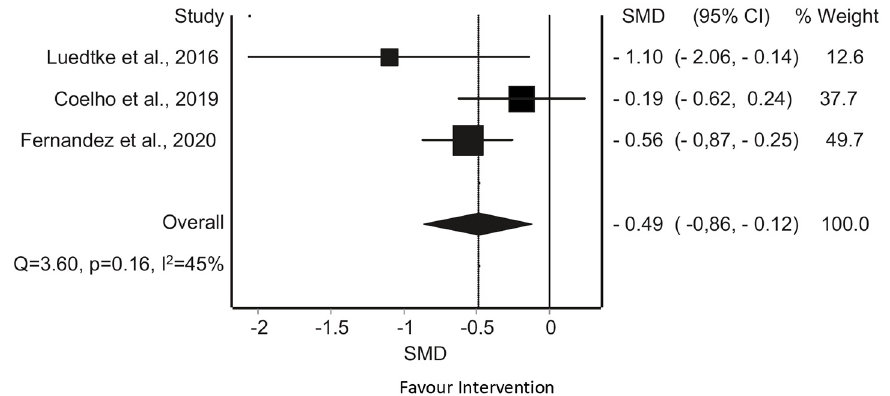
Figure 8. Synthesis forest plot for pain intensity in patients with cervicogenic headache and a mixed intervention. The forest plot summarizes the results of included studies (review size, standardized mean differences [SMDs] and weight). The small boxes with the squares represent the point estimate of the effect size and sample size. The lines on either side of the box represent a 95% confidence interval (CI).